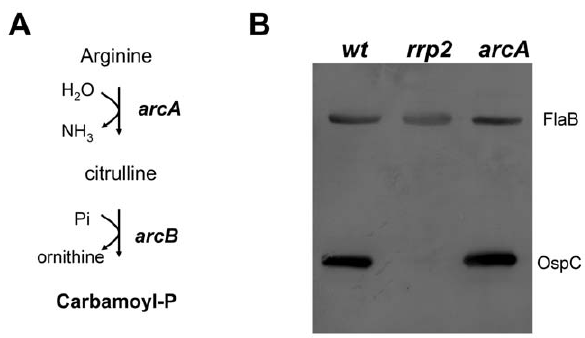
Figure 6. Inactivation of the carbamoyl-P biosynthesis pathway does not affect Rrp2 activation. ( A ) Diagram of the arginine fermentation pathway in B. burgdorferi . The arcA (bb0841) and arcB (bb0842) genes are predicted to encode arginine deaminase and ornithine carbamoyltransferase, respectively. ( B ) Immunoblot analysis of whole cell lysates of wild-type ( wt ), the rrp2 mutant [ rrp2(G239C) ], and the arcA mutant ( arcA ) with a mixture of antibodies against OspC and FlaB. Spirochetes were cultured at 35 u C and harvested at late logarithmic growth. The bands corresponding to FlaB and OspC are indicated on the